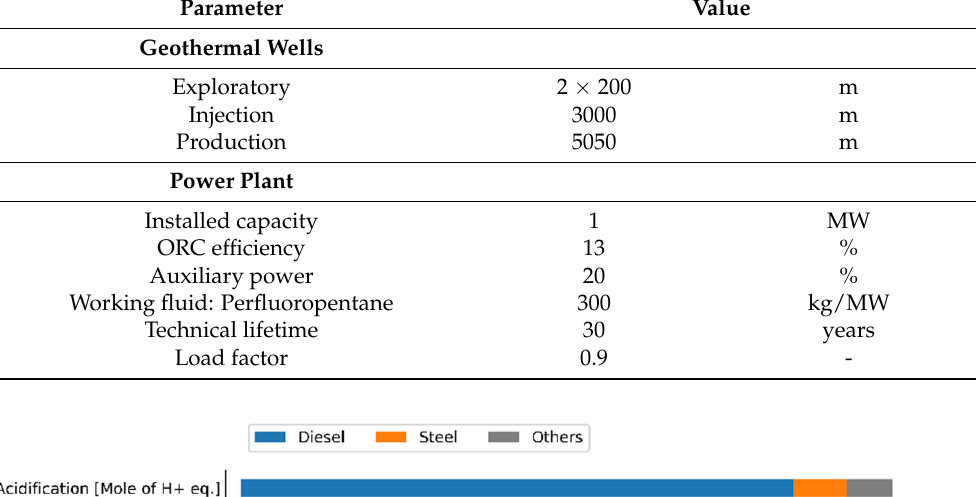
Table 1. Key LCA parameters for UDDGP [22].